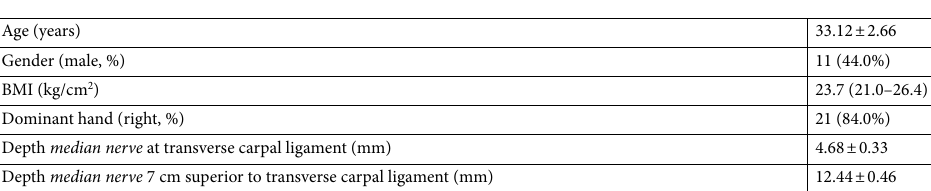
Table 1. Characteristics of the study population. Data represented as mean ± SEM. Gender and Dominant hand are represented as percentages (%). BMI is represented as median (IQR). BMI Body Mass Index.